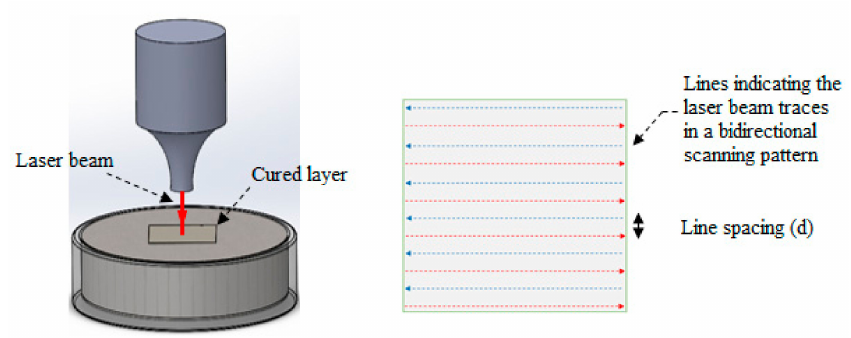
Figure 2. The schematic of the bidirectional raster laser